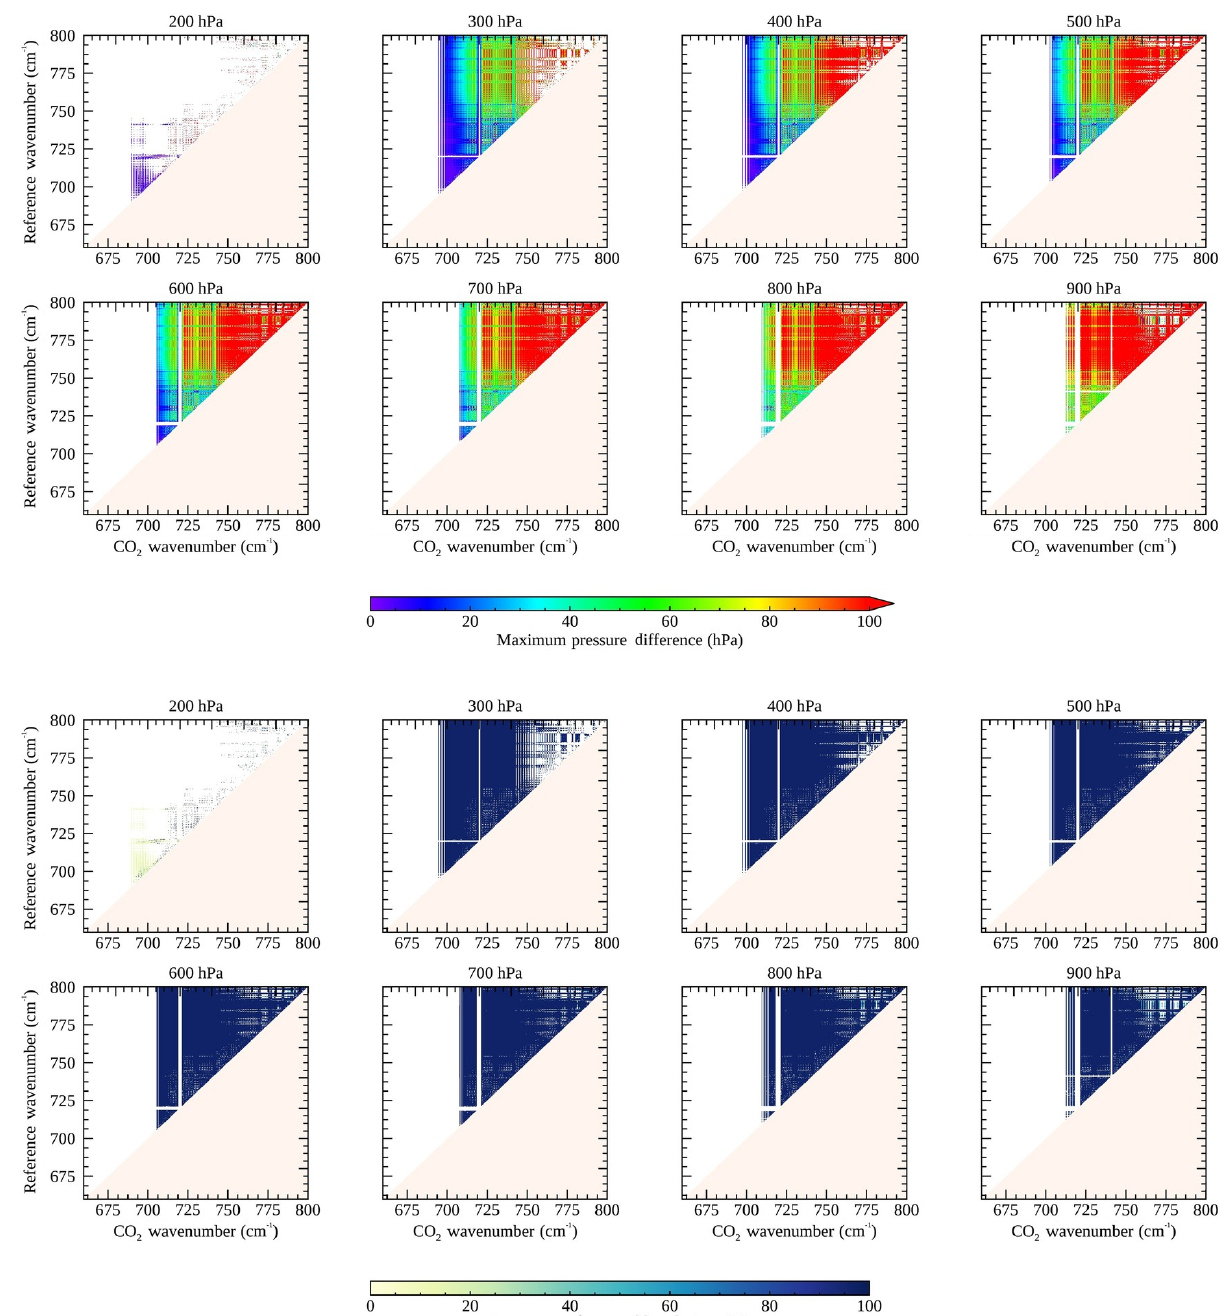
Figure A6. Same as Fig. A1 for a polar winter